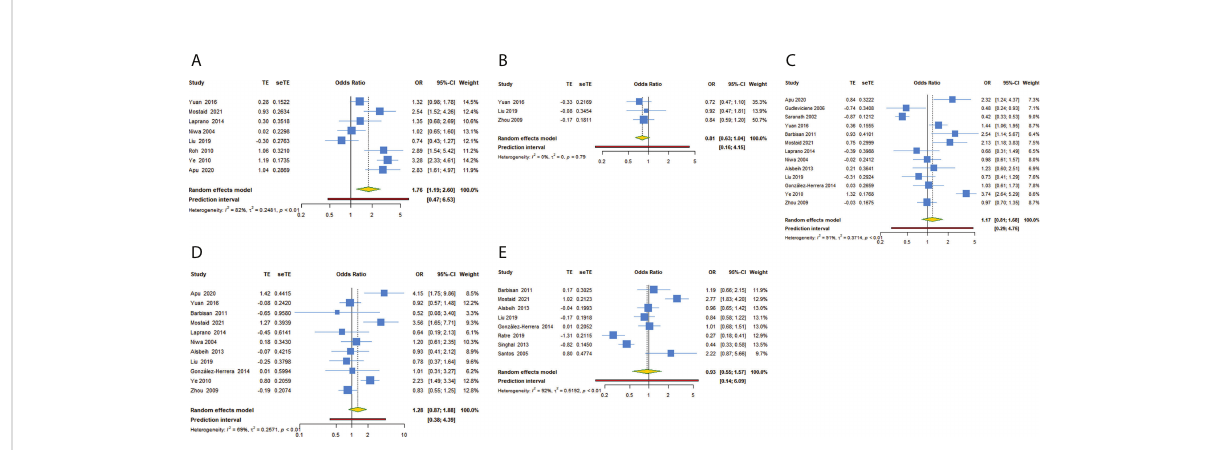
FIGURE 3 Forest plot of TP53 rs1042522 polymorphism and cervical cancer susceptibility (allele C as the effect allele) in fi ve models. (A) CC + CG vs GG; (B) CC vs CG + GG; (C) CG vs GG; (D) CC vs GG; (E) C vs